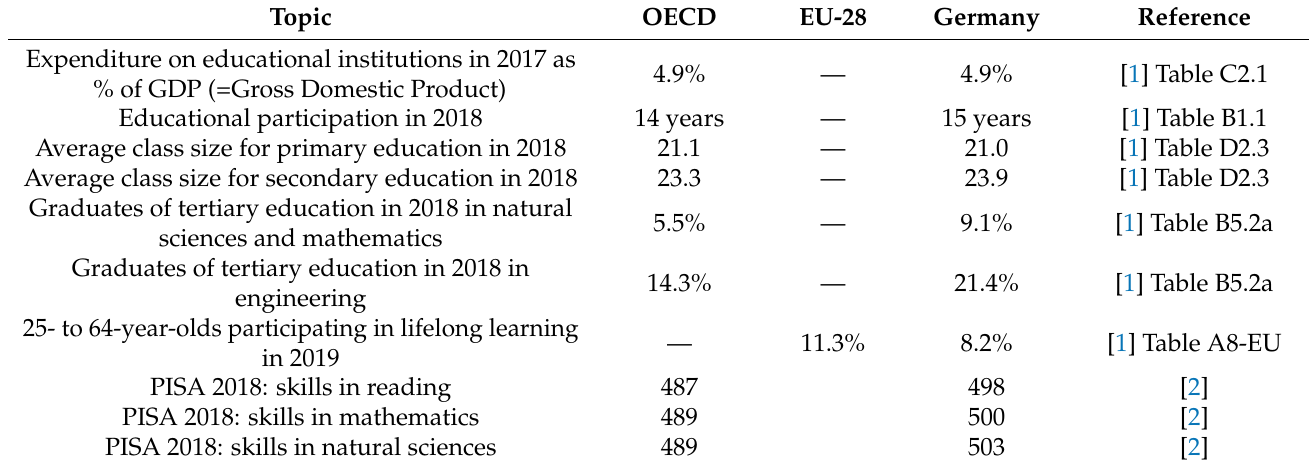
Table 1. Education in figures. Comparison of average values in the educational sector in the OECD (=Organisation for Economic Co-operation and Development), EU-28 (=28 member states of the European Communion until January 2020), and Germany